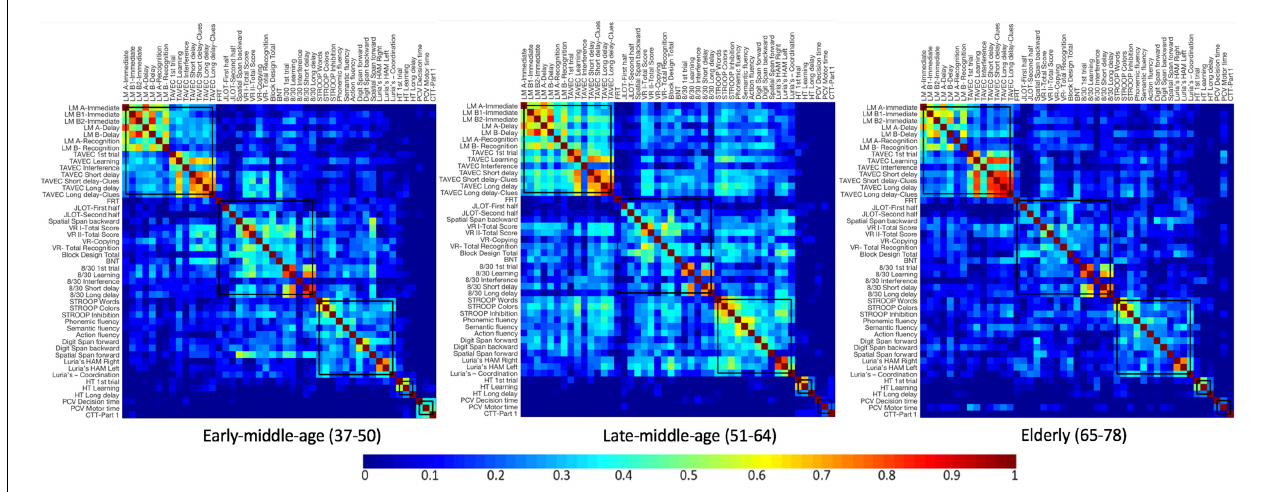
FIGURE 5 | Correlation matrices for each age group, keeping the five modules from the whole cohort fixed. Newman algorithm was used for modular analysis. Pearson’s correlation coefficients were used to build the matrix. The color bar indicates the strength of the Pearson’s correlation coefficients: colder colors represent weaker correlations, while warmer colors represent stronger correlations. See Supplementary Figures 2–4 for matrices with larger size and labelled regions. LM, Logical Memory; FRT, Facial Recognition Test; JLOT, Judgment of Line Orientation Test; VR, Visual Reproduction; BNT, Boston Naming Test; HT, Hanoi Tower; PCV, PC-Vienna System; CTT, Color Trails